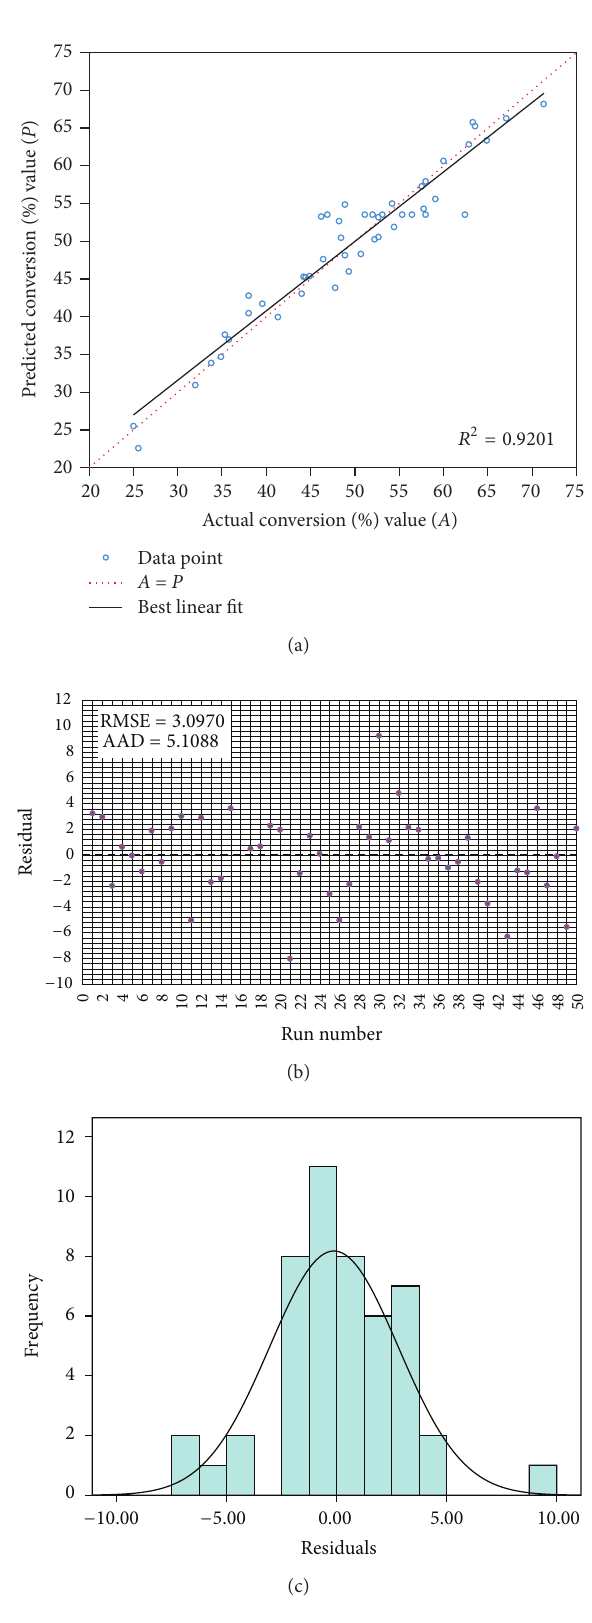
Figure 1: (a) Scatter plot of predicted conversion% value versus actual conversion% value (b) residual plot of runs from central com- posite design (c) histogram of residuals with normal